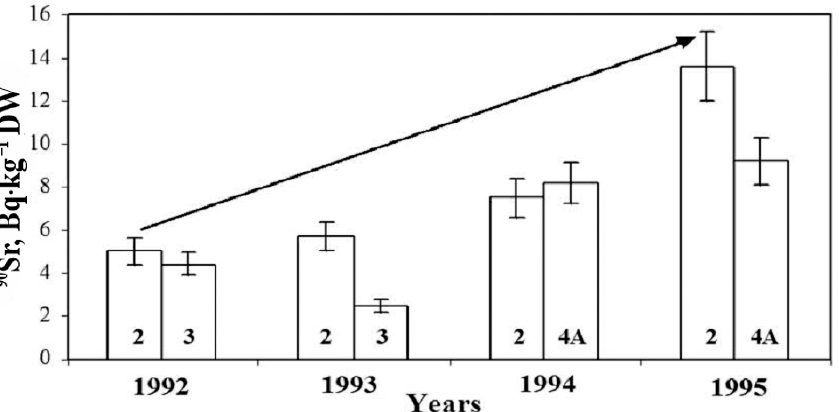
Figure 7. 90 Sr concentrations in soils under alfalfa (0–5 cm layer) in 1992–1995 at various sampling stations (stations 2 and 3—sampling station on the main canal, as 4A—sampling station on the outlet